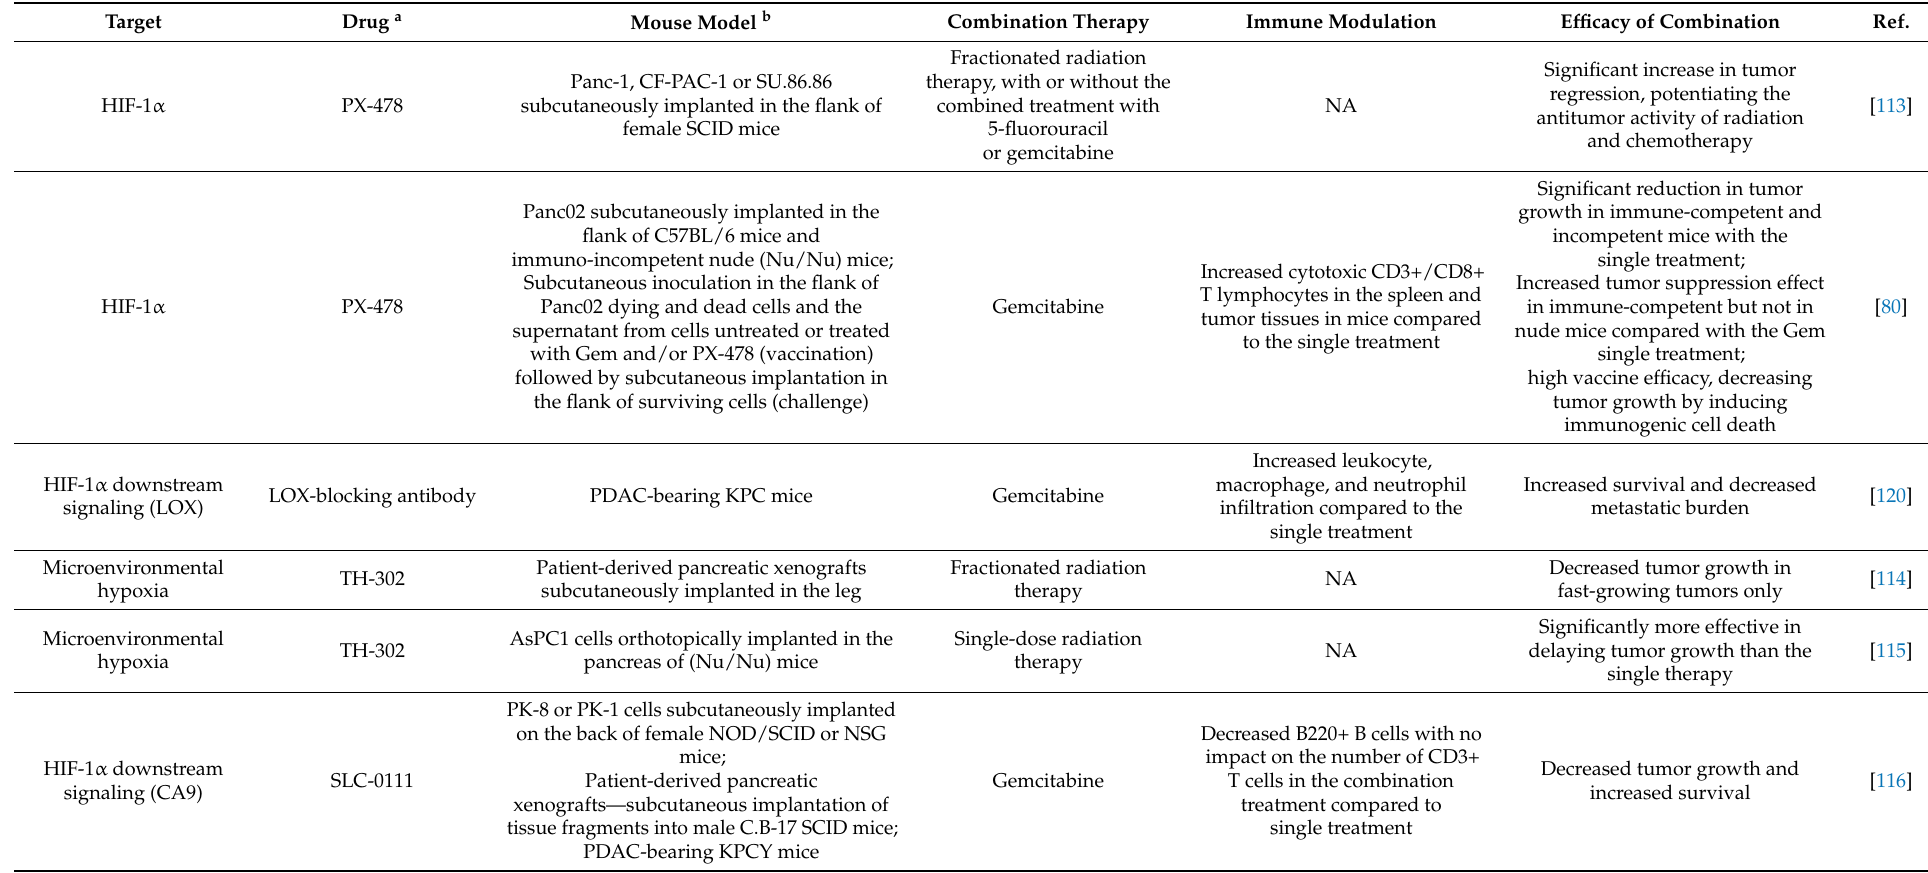
Table 2. Preclinical studies combining hypoxia-targeting strategies with conventional therapy in